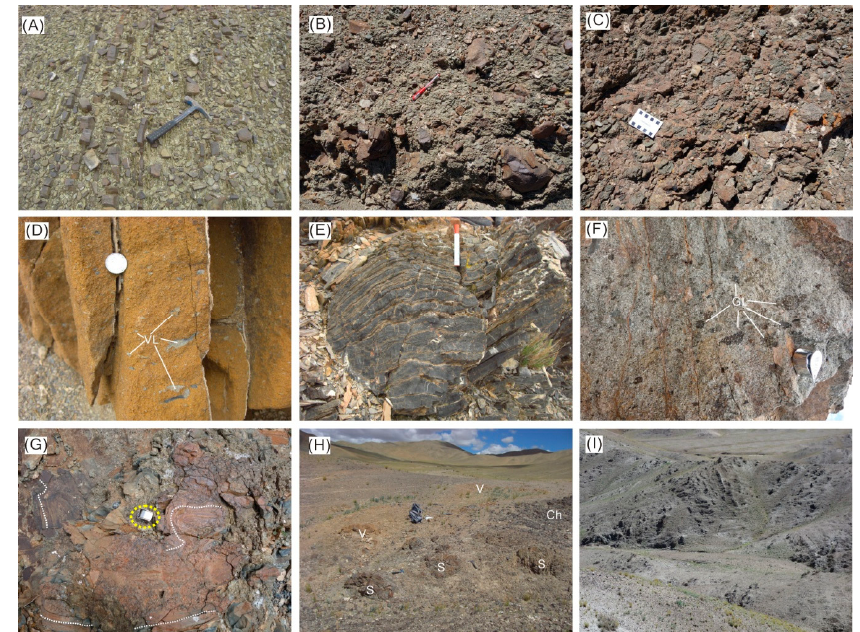
Figure 6. Typical field exposures of the MG subunits. ( A ) Interbedded graded sandstones and mudstones of subunit Tr ma . The hammer as scale is ~30 cm long; ( B ) Normally graded conglomerate of the basal part of subunit Tr mb . The pebbly-cobbly sized clasts are dominantly sandstone with lesser carbonate and volcanic rocks. The ball-point pen is ~10 cm long; ( C ) Volcanic breccias intercalated within the basal part of subunit Tr mb . Volcanogenic material accounts for >85% of the overall constituents. Length of the scale card is 10 cm; ( D ) Volcaniclastic sandstone of subunit Tr mb . Light gray fragments are lithic lapillis (VL) with greater size than surrounding sands, suggesting a fall-out origin. Diameter of the coin as scale is ~1.5 cm; ( E ) Laminated calcisiltites of subunit TrJ mc interpreted as deep-water facies. Folding is resulted from later structural deformation rather than depositional processes. The marker is ~12 cm long; ( F ) Pyroclastic flow of subunit J md . The dark angular clasts are glassy lapillis (GL) and the finer white-gray clasts are dominated by feldspar and lithic fragments. The lens as scale is 4 cm; ( G ) Convoluted mudstones included in the bottom of the J md pyroclastic bed. The lens as scale is ~4 cm; ( H ) Typical block-in-matrix fabric of the MG mélange. The blocks are composed of sandstone (S), volcanic rocks (V), chert (Ch) and carbonate. The bag is ~50 cm long; ( I ) A view (looking toward the southwest) of the broken formation type mélange resulted stratally-disrupted Tr ma sediments. Note the dark greenish color as a result of lower greenschist metamorphism.